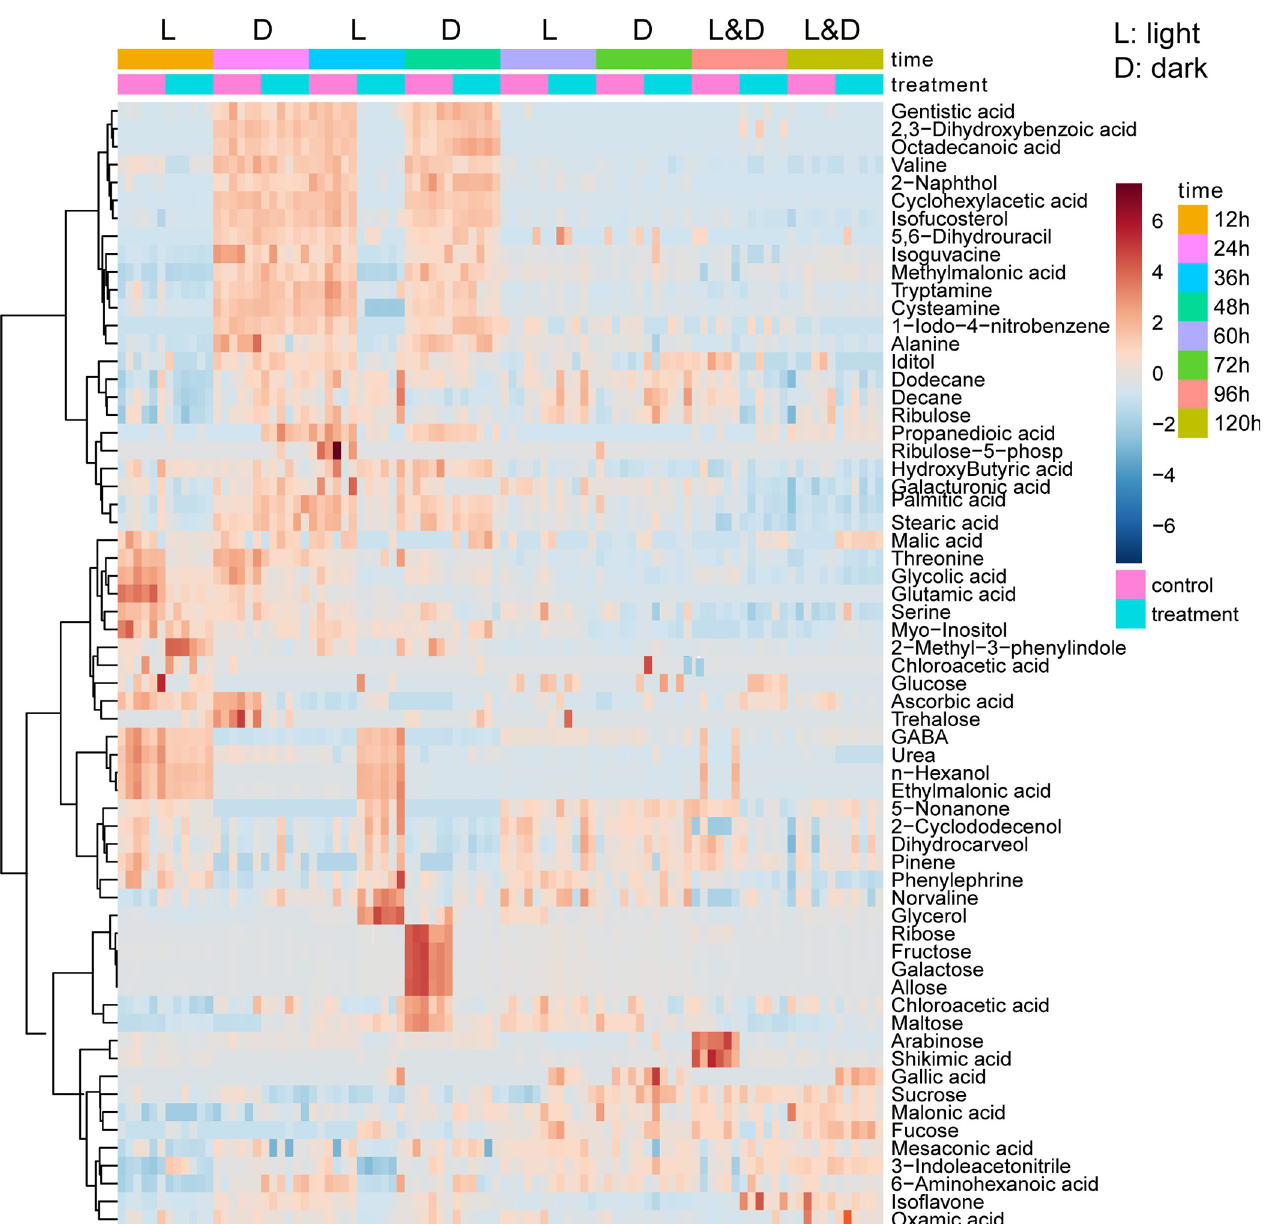
Fig 3. Heatmap analysis, combined with a hierarchical cluster analysis (HCA), of the metabolites in U . prolifera fragmentation-induced proliferation (treatment and control groups) during the 12–120 h period (n = 6). In the first line “L” represents light and “D” represents dark; In the second/time line colors represent different time; in the third/treatment line, the color pink represents the “control group” and green represents the “treatment